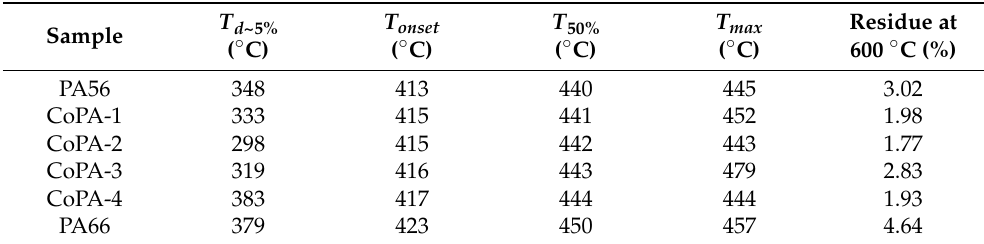
Table 3. TGA and DTG results for the PA56/66